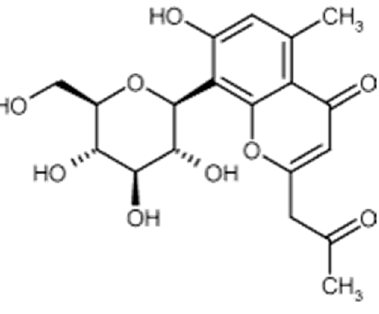
Figure 3. Aloesin formula.